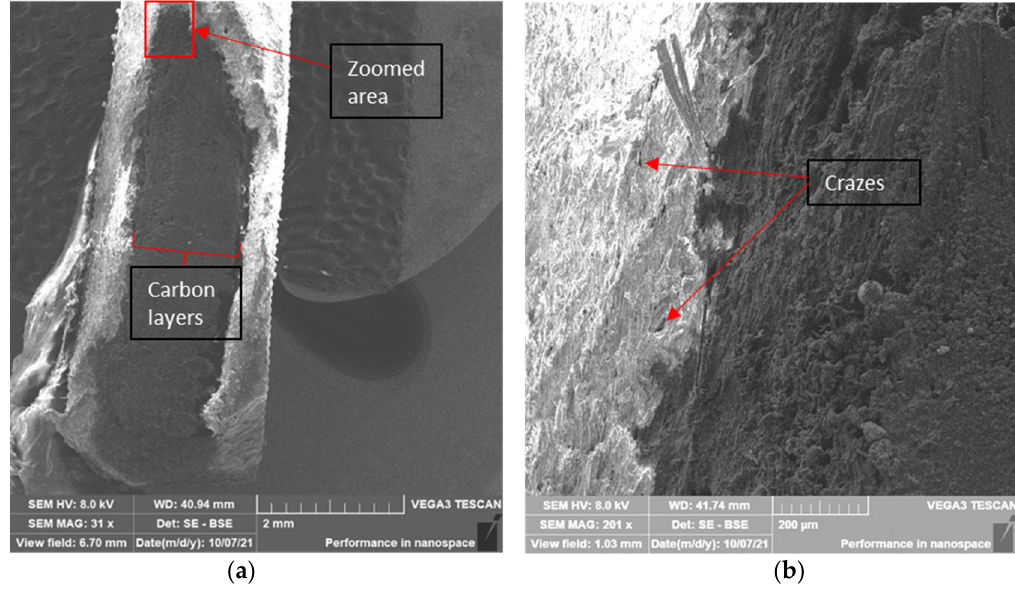
Figure 12. SEM transversal cut of a 55/110 layers carbon fiber on-edge printed sample: ( a ) 31×, ( b ) 201×.